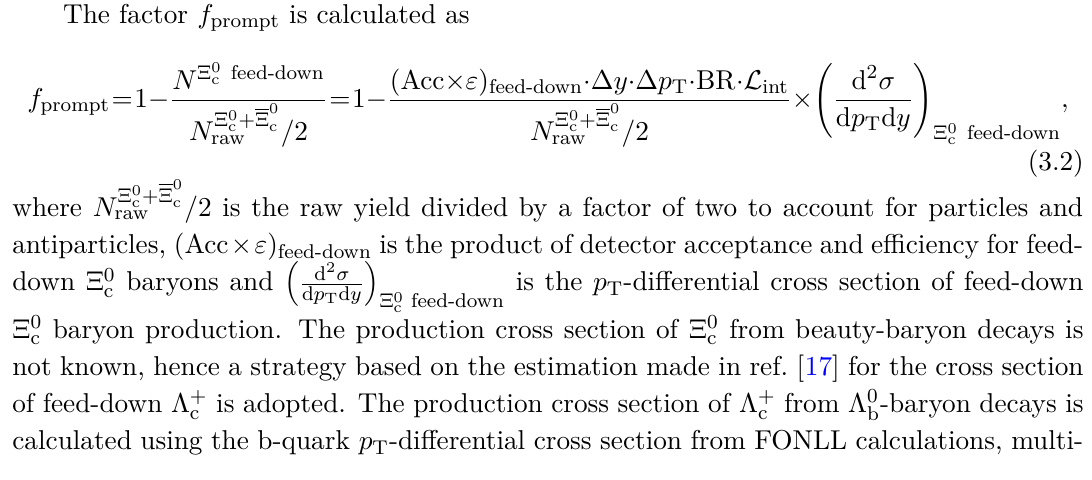
Ξ − π + ) = 1.36 ± 0.14 (stat.) ± 0.19 (syst.), measured by ALICE in pp collisions at